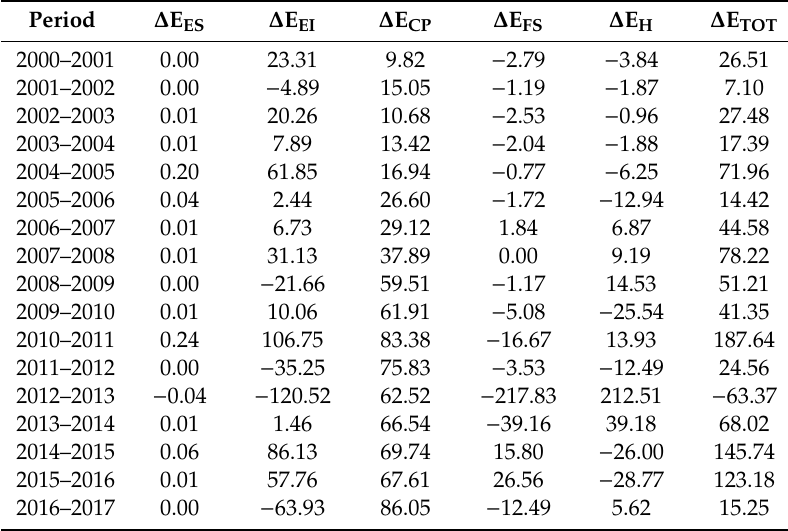
Table A4. Detailed decomposition results of REC in rural Guangdong,